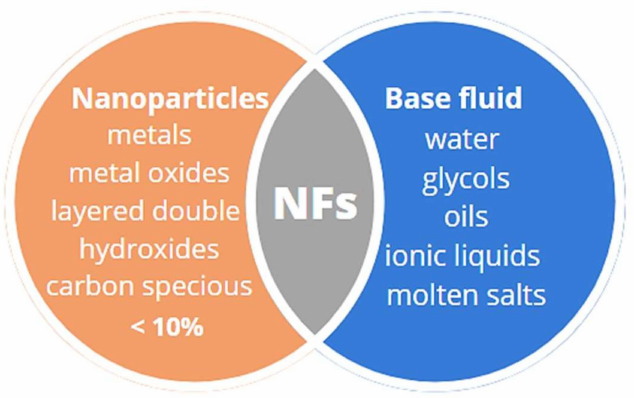
Figure 5. The composition of heat transfer